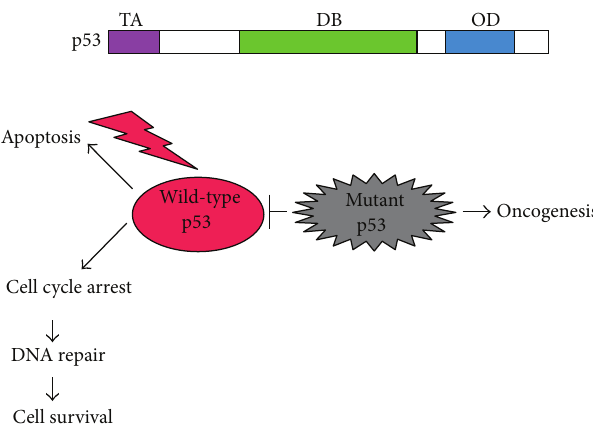
Figure 2: Structure of p53 and dominant-negative behavior of mutant p53 toward wild-type p53. p53 is composed of three func- tional domains including NH 2 -terminal transactivation domain (TA) followed by central sequence-specific DNA-binding domain (DB) and COOH-terminal oligomerization domain (OD) (upper panel). Lower panel shows the dominant-negative behavior of mutant p53 against wild-type